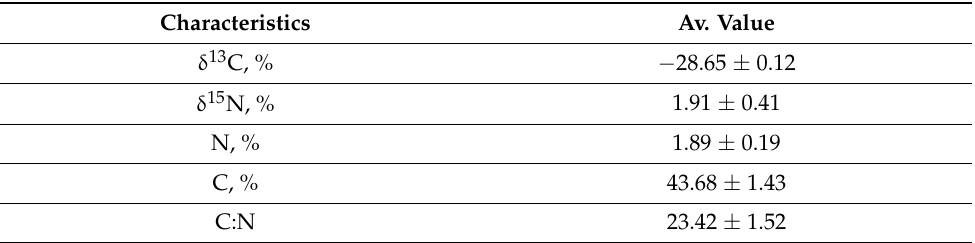
Table 3. Bovine faeces chemical characteristics (average ± standard error): concentration of C and N, C/N ratio and isotopic composition of N ( δ 15 N) and C ( δ 13